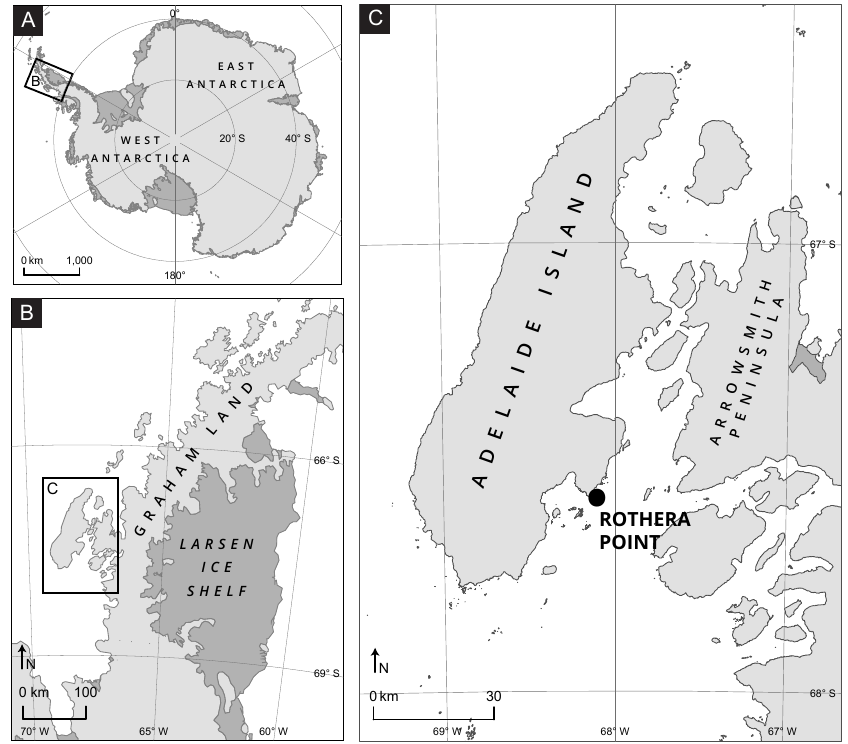
Figure 1. Location maps showing the context within Antarctica ( A ); the location of Adelaide Island within the Antarctic Peninsula ( B ) and the location of Rothera Point in the context of Adelaide Island ( C ; black dot).